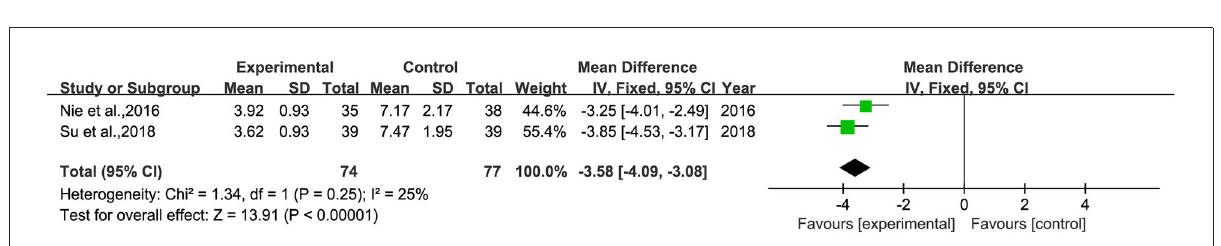
FIGURE9 Meta-analysis of BHD and antidepressants regarding TESS scores. Green: